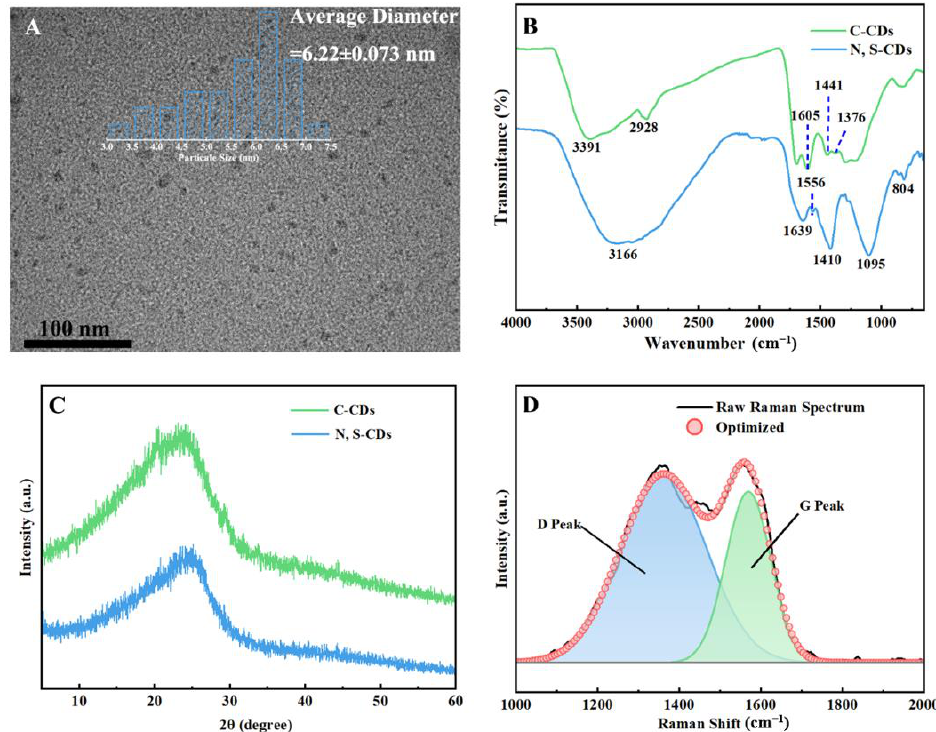
Figure 2. TEM image and histogram of the size distributions of N, S-CDs ( A ), FT − IR spectra of C-CDs and N, S-CDs ( B ), XRD patterns of C-CDs and N, S-CDs ( C ), and Raman spectra of N, S-CDs ( D ).